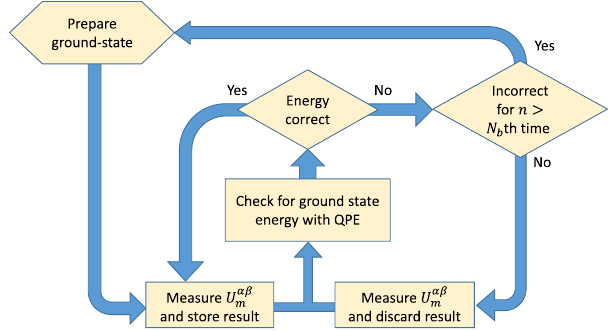
FIG. 3. Overview of the incoherent estimation of the Green ’ s